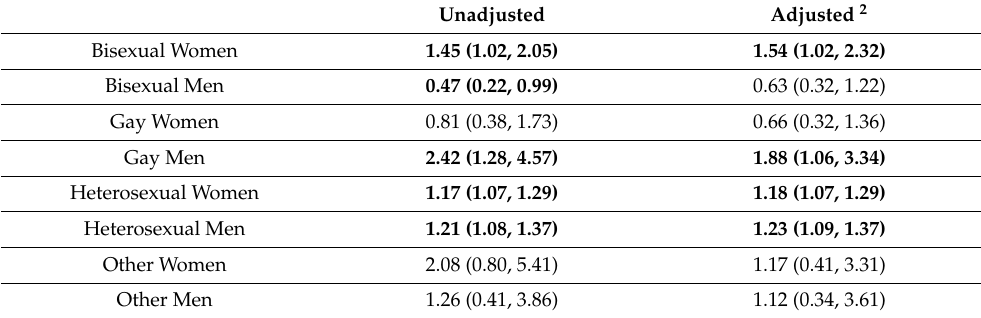
Table 2. Trend ratios 1 for time associated with health care access and satisfaction scale, stratified by sexual identity ( n = 28,961).